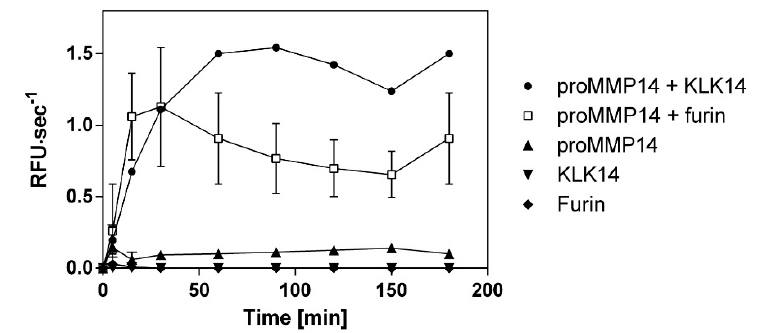
Figure 5. Comparison of recombinant human proMMP14 activation by KLK14 and furin as a functional peptidase. ProMMP14 (10 nM) was incubated with KLK14 (3 nM) and furin (3 nM) in the presence of a fluorogenic substrate Mca-KPLGL-Dpa-AR-NH2. The final concentration of the substrate was 10 µM in the MMP reaction buffer (50 mM Tris, 3 mM CaCl2, 1 µM ZnCl2, pH 8.5). Hydrolysis was recorded for 180 min at 37 °C. The velocities were plotted in triplicates as mean ± SD using GraphPad Prism. Please note that the error bars may be occluded by the point markers and are not visible for some of the data points. KLK = kallikrein-related peptidase; MMP = matrix metalloproteinase.